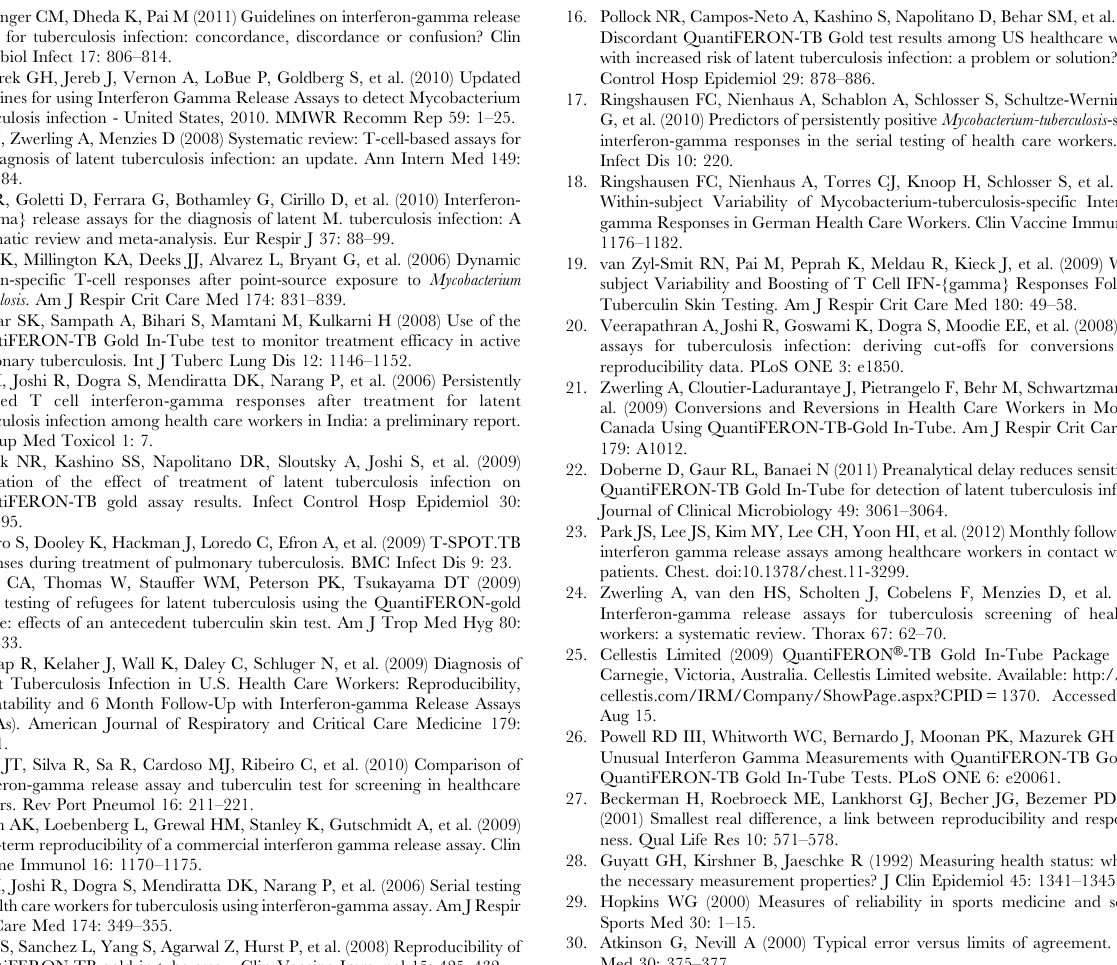
Table S2 Quantitative indices of variability using original data. Table S3 QuantiFERON-TB Gold In-Tube test results before and after correction of data entry errors. Table S4 TB and TB Response Values for 7 subjects with highest Lab3